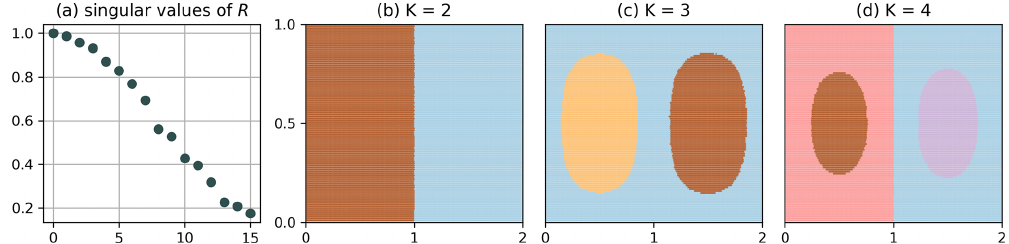
Figure B2. Clustering of Q for the autonomous double gyre with (cid:49)x = (cid:49)y = 0 . 15, i.e. a non-optimal partition, and the simultaneous K -way NCut (algorithm 1 in Sect. 3.3). The main separation at x = 1 is still resolved, but only at every even clustering step. The degeneracy of the singular values (see Fig. B1) is lifted.